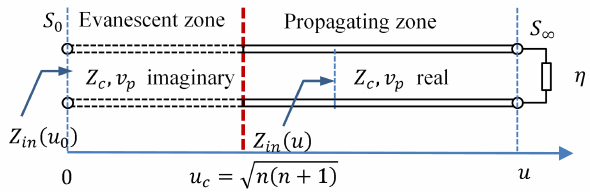
Figure 3. NTL model for TM nm